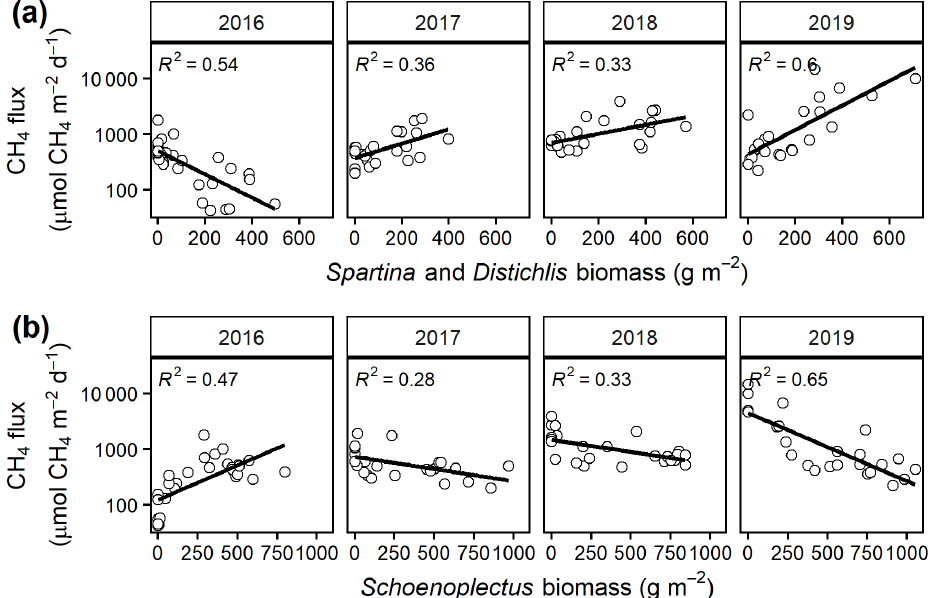
Figure 4. Mean growing season (May–September) CH 4 emissions from each plot versus the biomass of (a) C 3 ( Schoenoplectus ) and (b) C 4 ( Spartina and Distichlis ) plants. All regressions are significant at p =